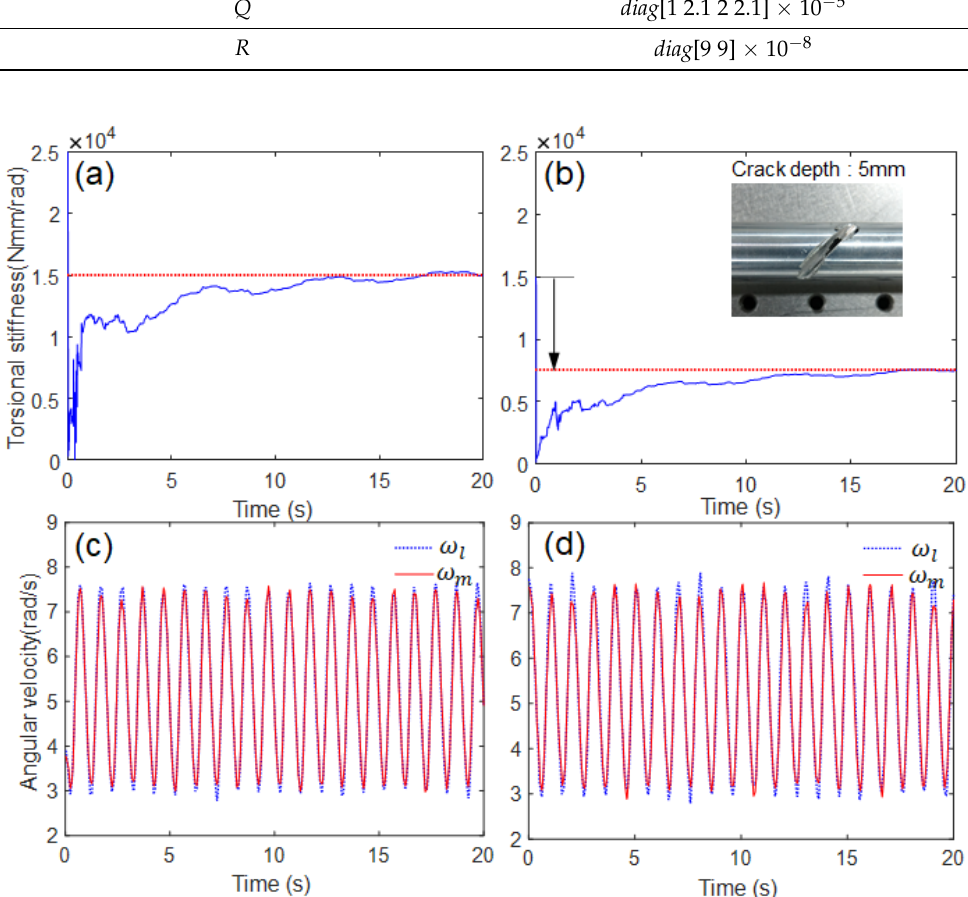
Figure 11. Experimental results: ( a , b ) estimated responses of torsional stiffness, ( c , d ) angular velocity inputs, ( a , c ) without crack, ( b , d ) with crack (crack depth 5 mm).